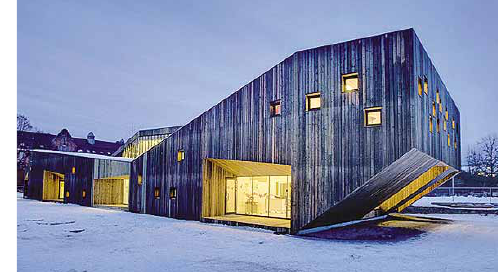
Fig. 7. House in Utriai, Klaipėda region, archit.